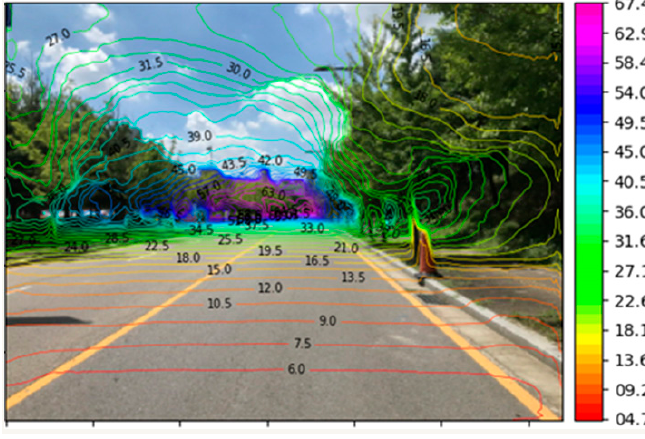
Figure 4. DenseDepth outdoor-road-depth-value-extraction